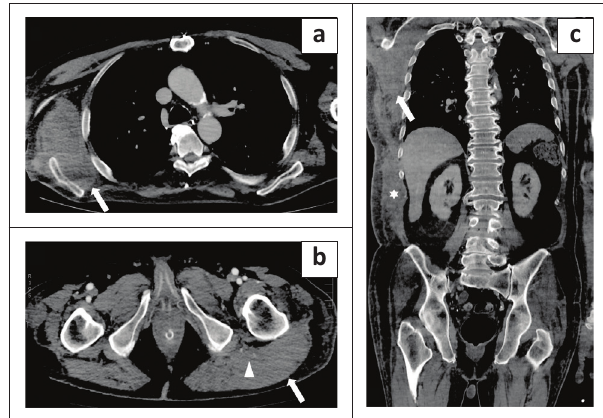
FIGURE 4: A 73-year-old man with multiple haematomas, the first diagnosed 18 days after hospital admission. (a) Axial plane, venous phase: right subscapular haematoma (arrow). (b) Axial plane, arterial phase: left gluteal haematoma (arrow) with a small blush in the inner part (arrowhead). (c) Coronal plane, venous phase shows the right subscapular haematoma (arrow) and a haematoma in the abdominal wall